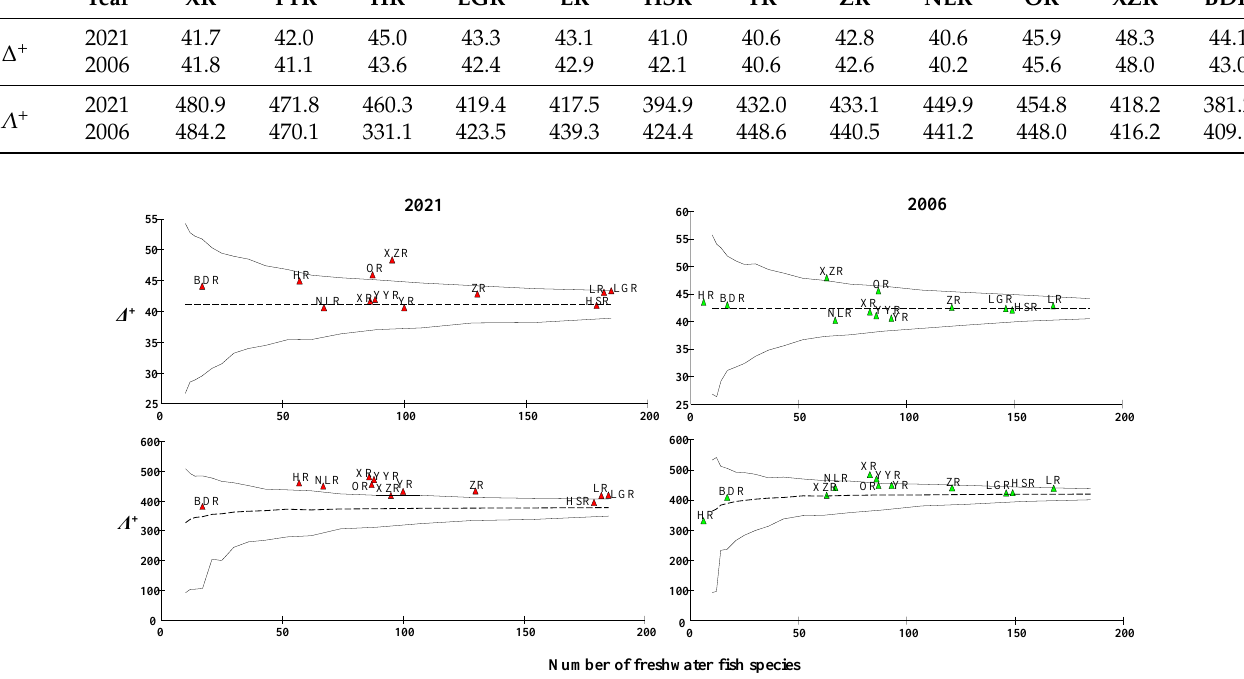
Figure 5. ∆ + and Λ + of 12 Sub − basins plotted against the number of species on the 95% confidence funnel in 2006 and 2021. (linear-the theoretical value, the two curves-incredible